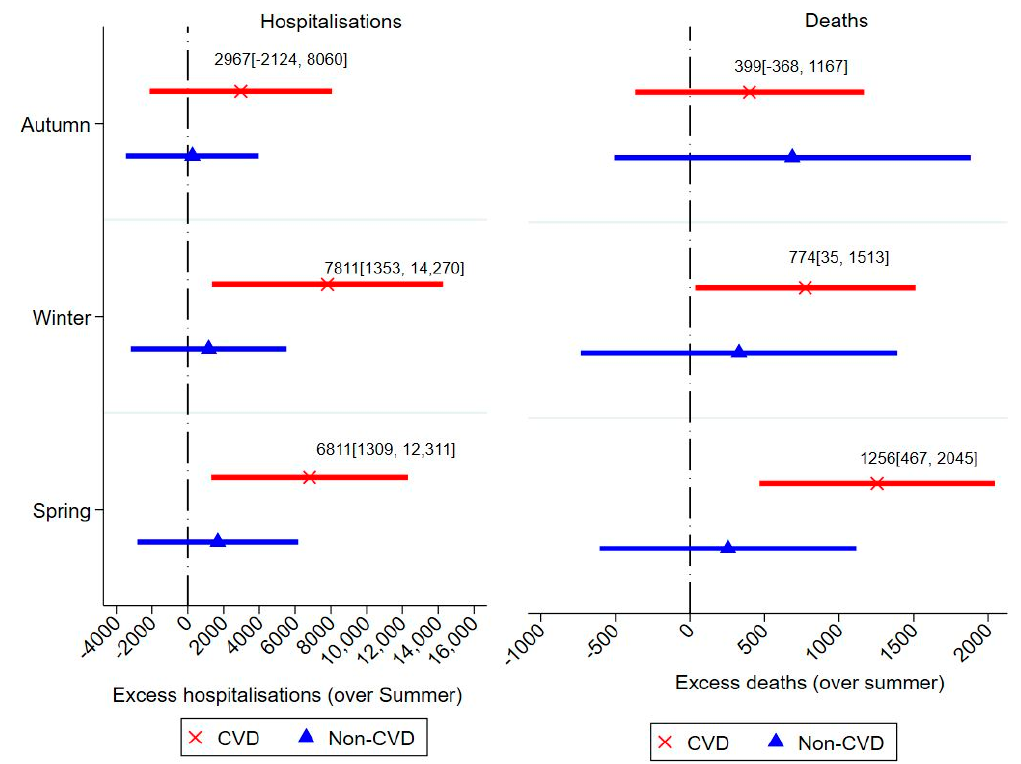
Figure 1. Excess CVD and Non-CVD events across seasons.